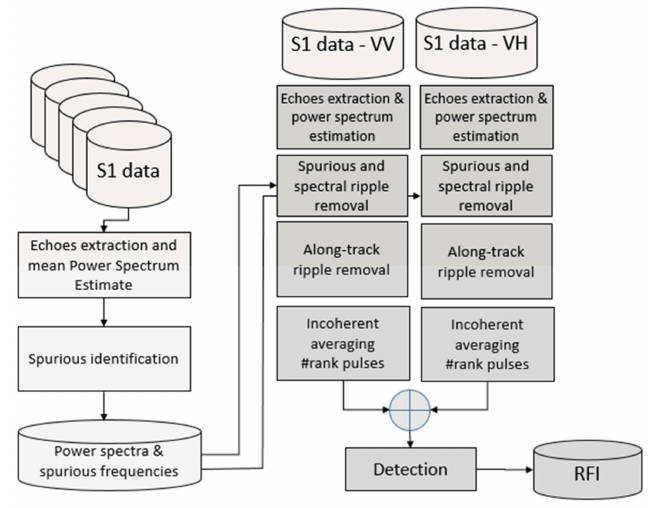
Figure 3. Schematic block diagram for the identification of RFI.